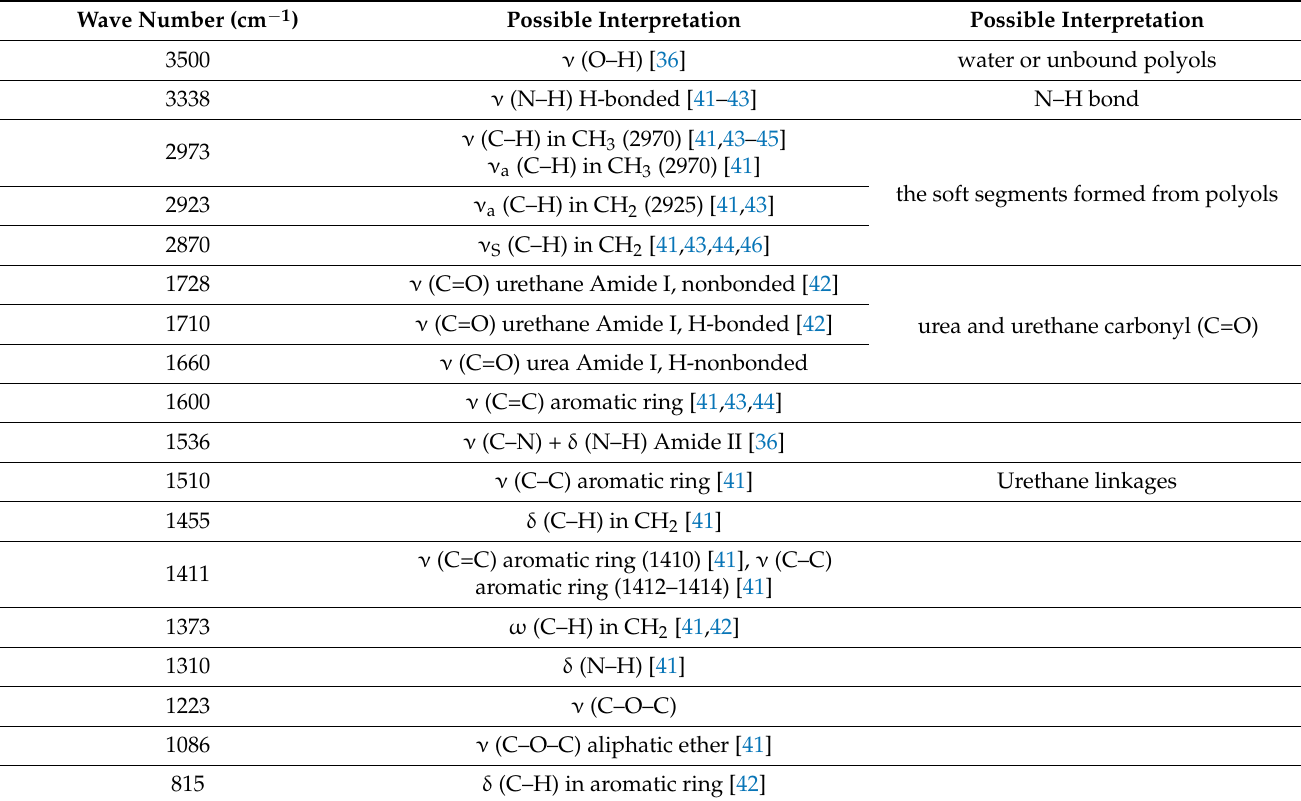
Table 6. Assignment of functional groups in Fourier transform infrared spectroscopy by attenuated total reflectance (FTIR-ATR)